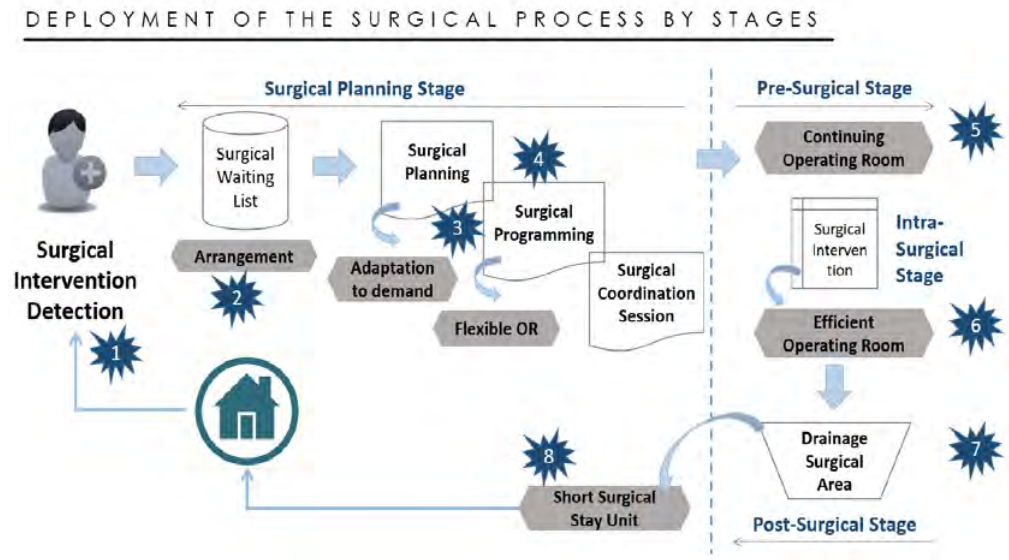
Figure 1. 4 Stages of the deployment of the global surgical process (8 Kaizen burst